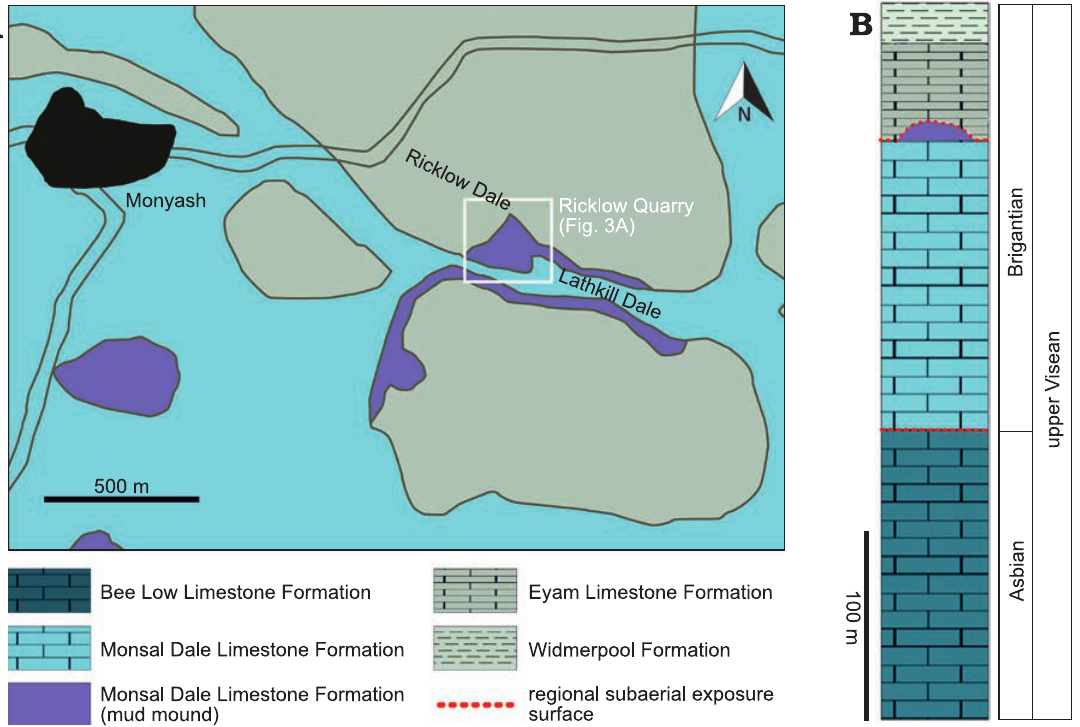
Fig. 2. Study area of Ricklow Quarry (Derbyshire, UK). A . Geological map of the surroundings of the village of Monyash and location of the site of Ricklow Quarry. Modified after British Geological Survey (1978). B . Stratigraphical column of the upper part of the Derbyshire Carbonate Platform succession in the study area around